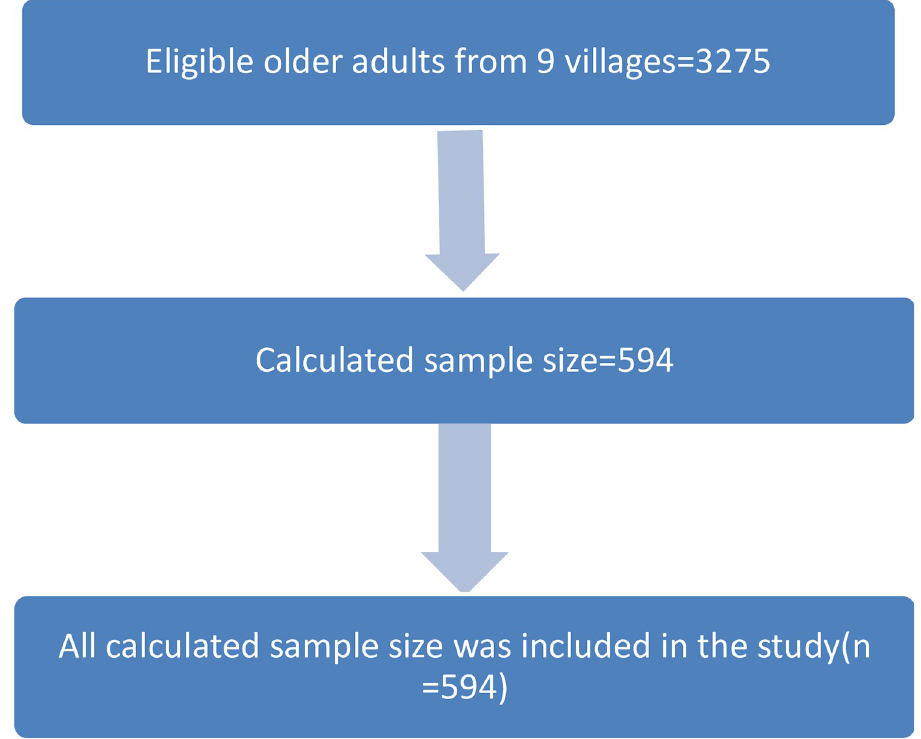
Fig 2. Study flow diagram of prevalence of undernutrition and its associated factors among older adults using Mini Nutritional Assessment tools in Womberma district, West Gojjam Zone, Amhara Region, North West Ethiopia,